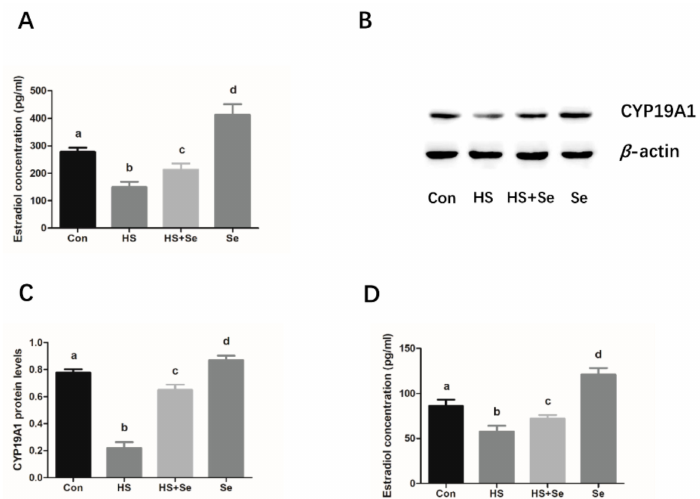
Figure 5. E ff ects of sodium selenite on estradiol levels in heat stress-treated granulosa cells and serum in mouse. Cells were treated with or without sodium selenite at 39 ◦ C for 24 h and then the concentration of estradiol in the culture supernatants was detected by an ELISA kit ( A ). Western blotting was used to analyze the protein expression of CYP19A1 ( B and C ). β -actin was used to normalize the protein expression levels. The mouse was orally administered sodium selenite for 4 weeks, and the estradiol level in the serum was detected by an ELISA kit ( D ). The statistical analysis results are shown as bar graphs. The data are represented as the mean ± SEM of three independent experiments, and each independent experiment includes three technical replicates. Bars with di ff erent lowercase letters are significantly di ff erent ( p <